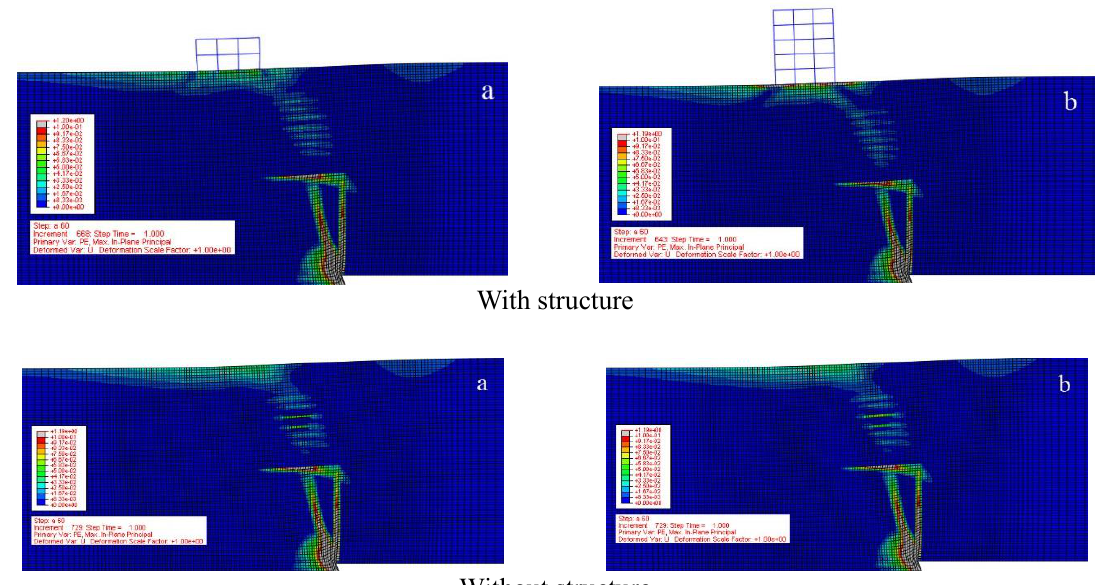
Fig. 15. Fault route in two soil layer with DS-LS density: (a) 2 floors and (b) 5